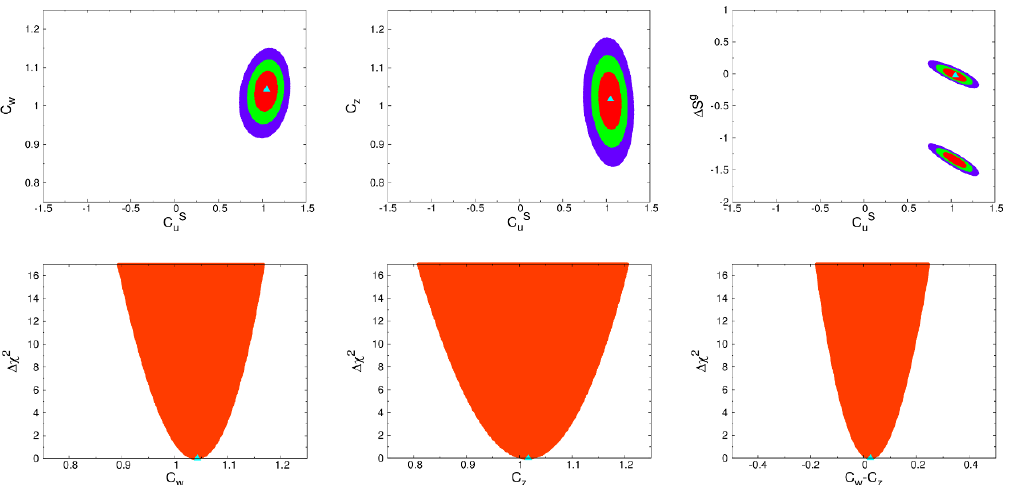
Figure 11 . CPCX4 : (Upper) The con(cid:12)dence-level regions of the (cid:12)t by varying C w , C z , (cid:1) S g , and C S . The color code is the same as in (cid:12)gure 2. (Lower) (cid:1) (cid:31) 2 versus C w (left), (cid:1) (cid:31) 2 versus C z u (middle), and (cid:1) (cid:31) 2 versus C w (cid:0) C z (right).